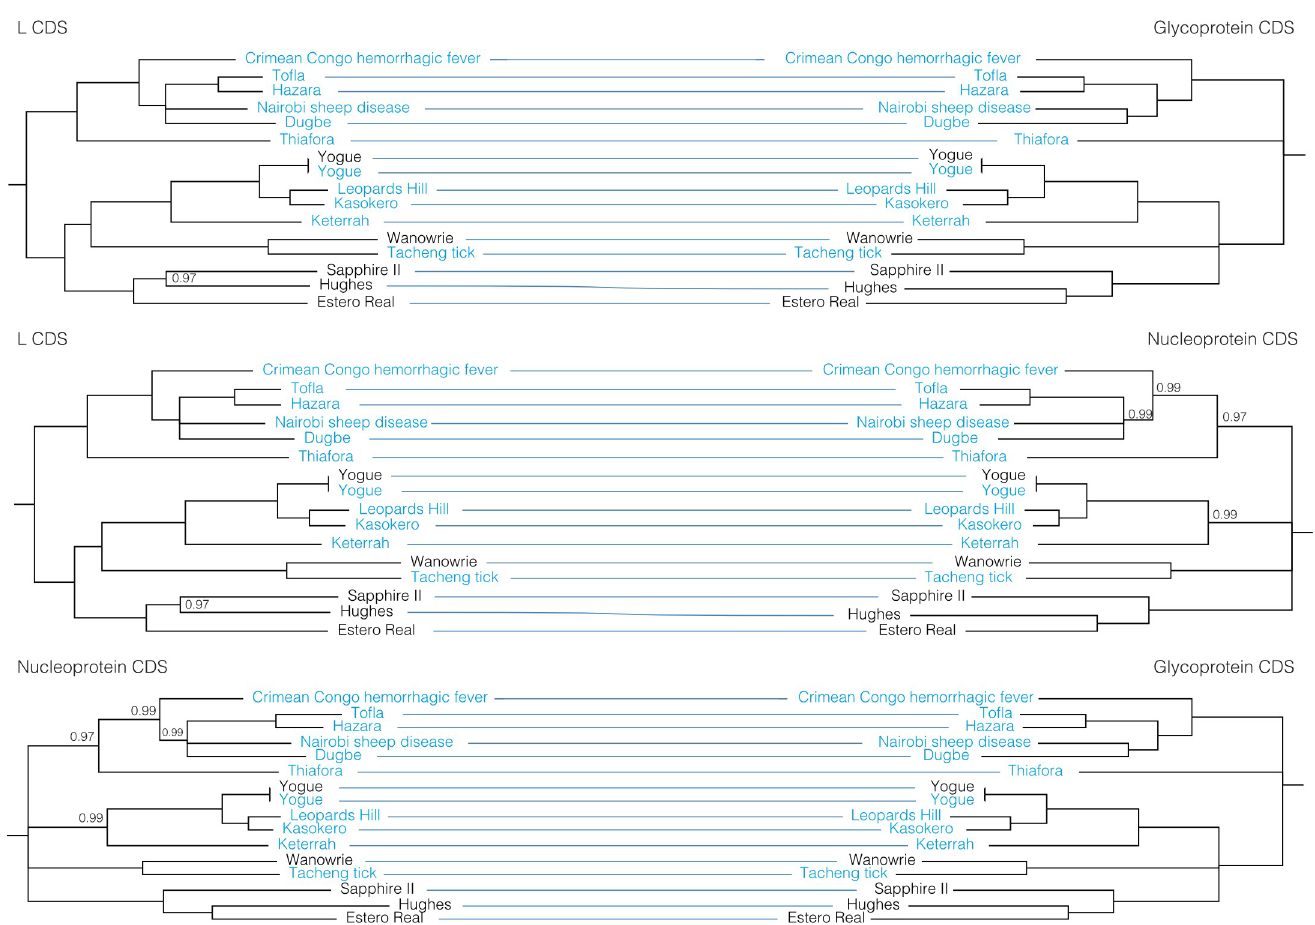
Fig 10. Co-phylogenies of Nairoviridae L, M, and S segment trees. Branches with support values < 0.95 were converted to polytomies. All other branch support values were 1 unless indicated. Trees were rooted with outgroups as in Fig